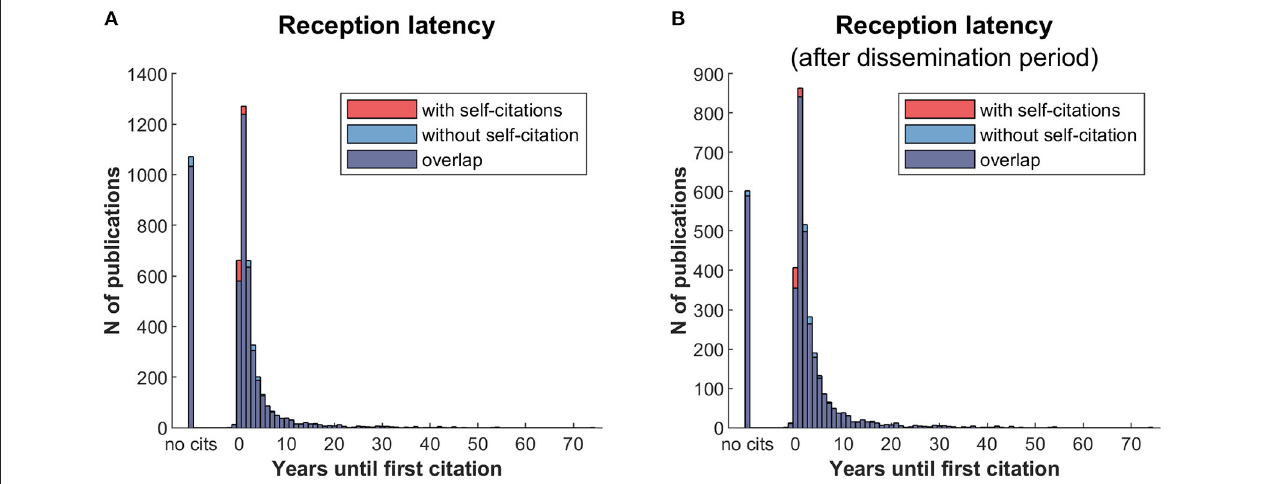
FIGURE 11 | Reception latency. (A) Years until first citation for all JIPS articles. (B) Years until first citation including dissemination latency of 5 years, i.e., including only articles aged 5 years and older. Results resemble those from A, but with (expectedly) fewer non-cited